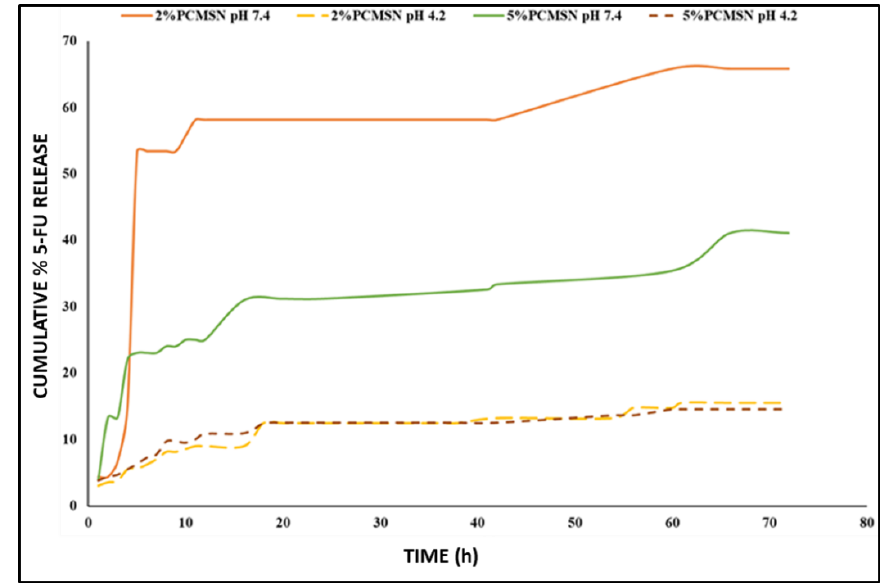
Figure 4. Drug release profile of 5-FU at pH 7.4 (solid lines) and pH 4.2 (long-dashed lines) for 2% PEG-CHIT-MSN (orange and yellow) and 5% PEG-CHIT-MSN (green and dark brown).